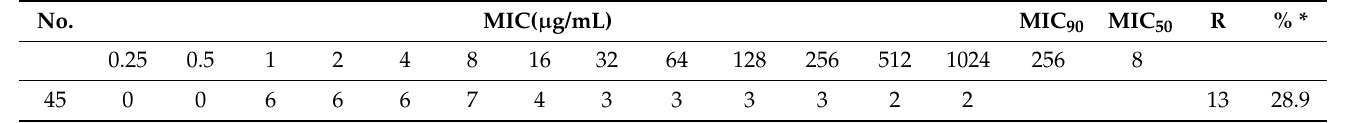
Table 2. Distribution of MIC, MIC 90 , and MIC 50 of amikacin among the isolated P. aeruginosa . No.